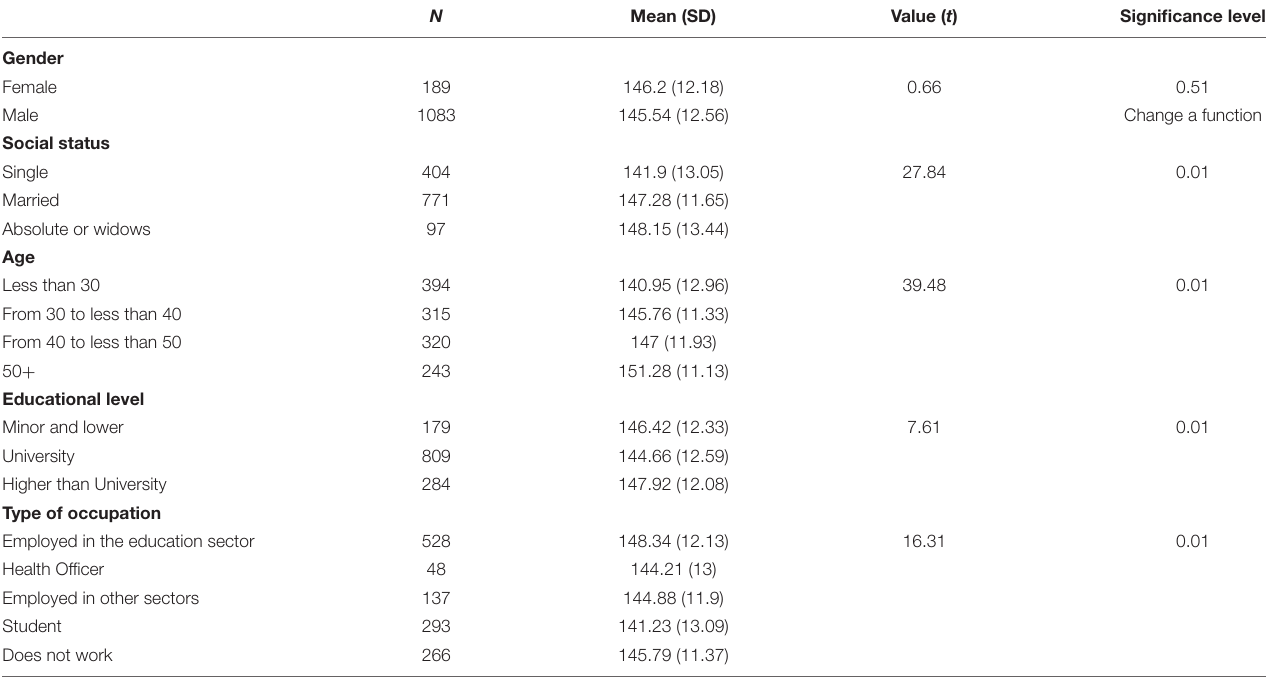
TABLE 4 | T -test, one-way contrast analysis and the Mann–Whitney Tests examining differences in the psychological responses to the COVID-19 pandemic across demographic variables. N Mean (SD)